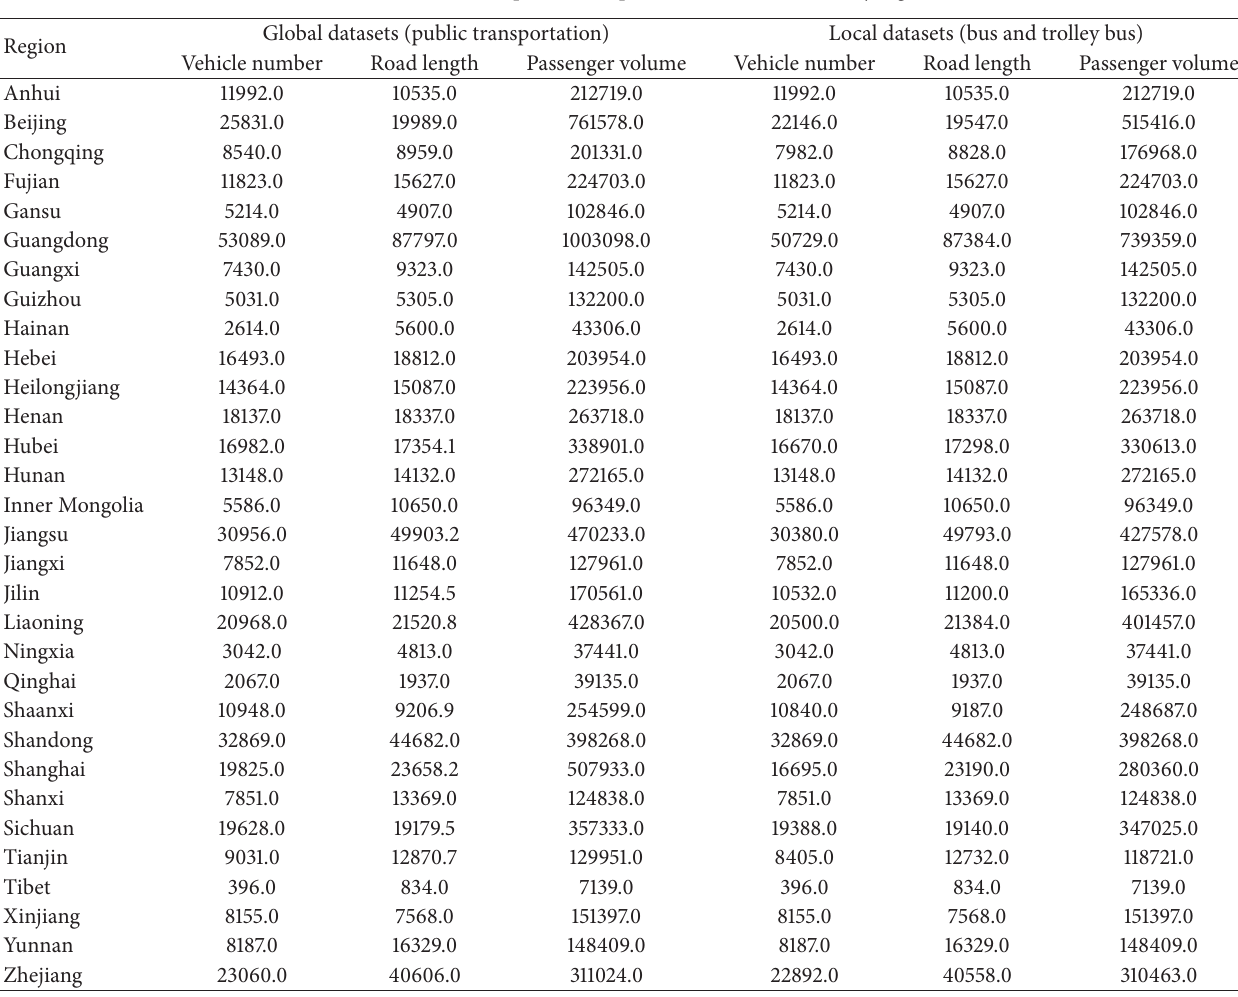
Table 2: Basic datasets on the public transportation in China’s cities by region